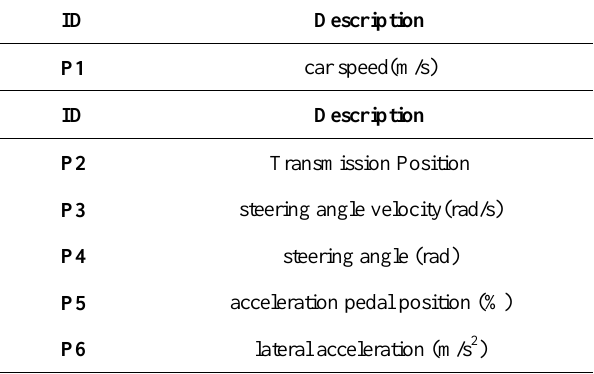
Table 1. Vehicle dynamic parameters used in our system